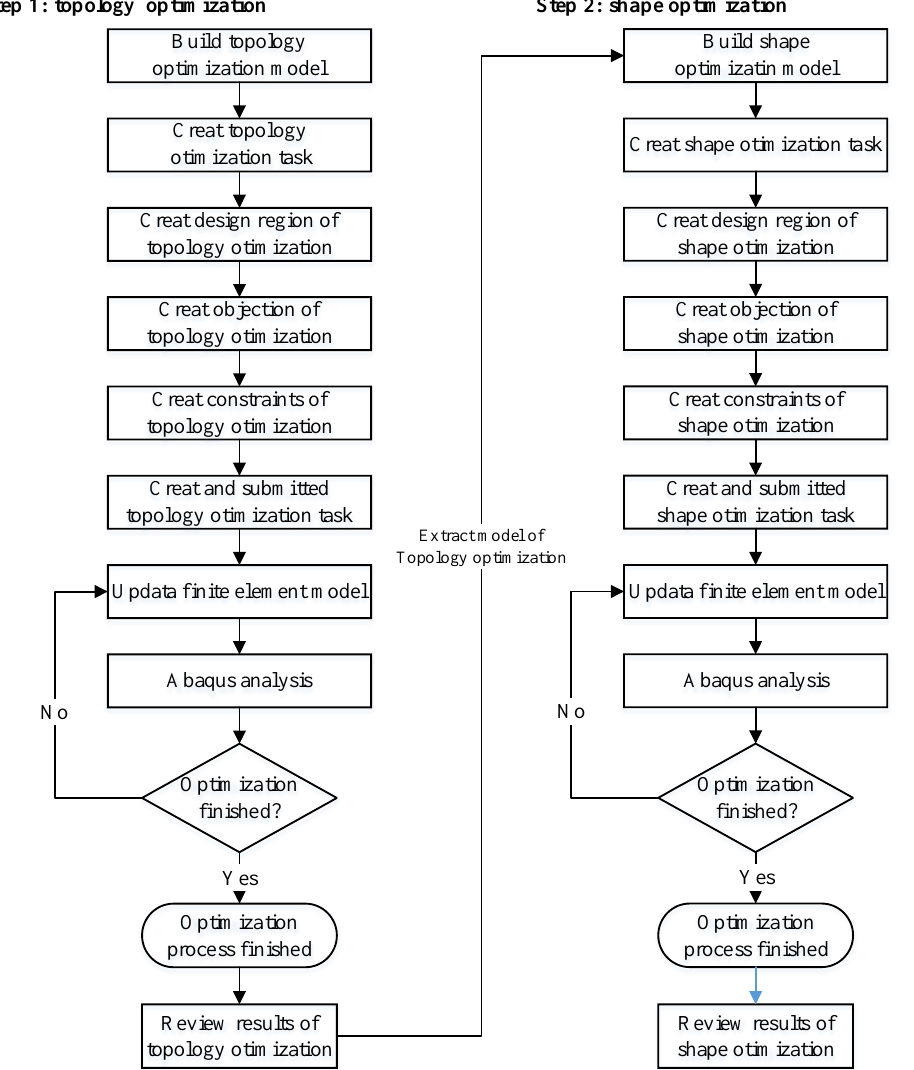
Figure 21. Topology and shape optimizations of the cruciform specimen. Figure 22 shows the cruciform specimen for the in-plane biaxial test at 1700 ◦ C. Four clamps were used to clamp the cross arm of the cruciform specimen, and the control mode was set to force control. Tests of cruciform specimens with different force propor- tions under 1700 ◦ C can be carried out by specifying force values in both horizontal and vertical